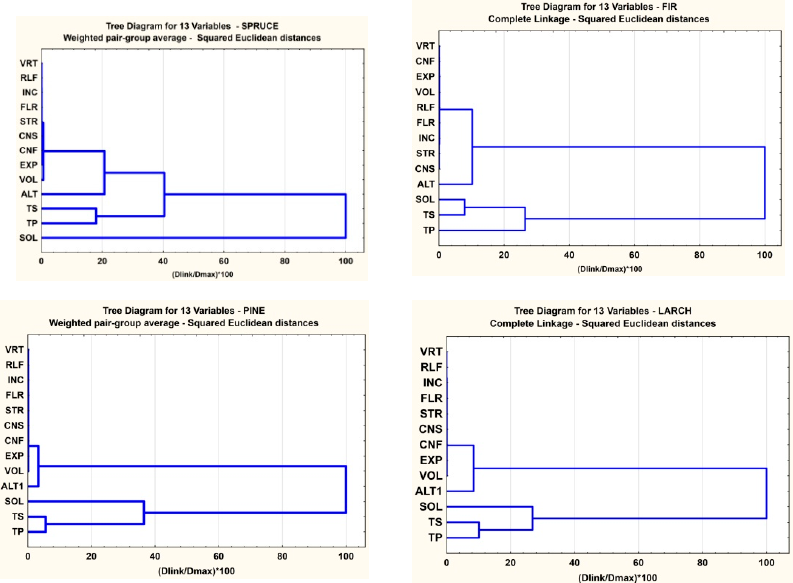
Figure 13. Cluster diagram: weighted pair-group average squared Euclidean distances.